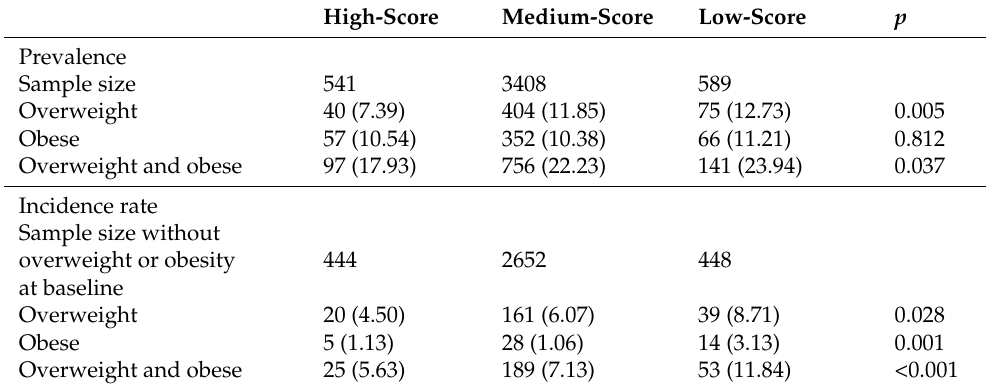
Table 3. Prevalence (baseline) and incidence rate (follow-up) of overweight and obese children ( n